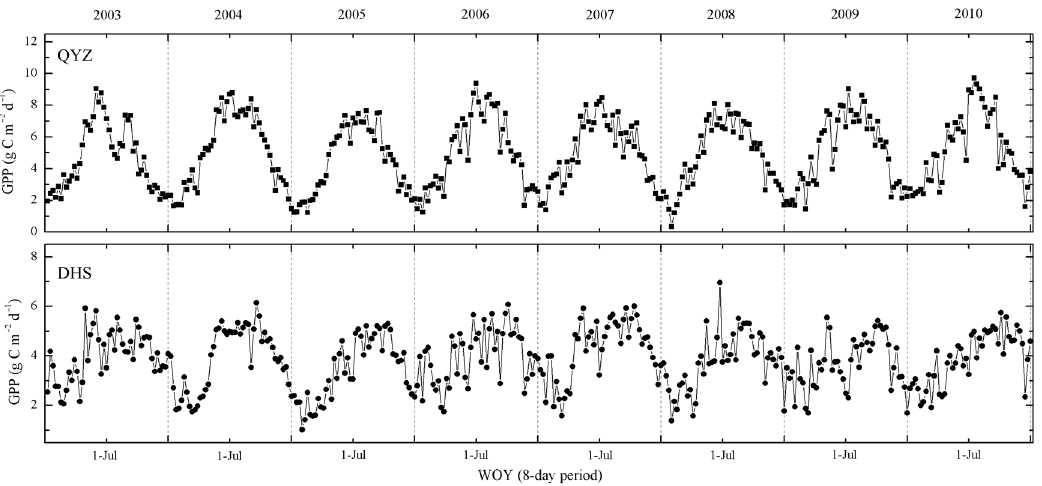
Figure 2. Site-level GPP observations at the two subtropical forest flux sites (QYZ and DHS) for 8-day periods from 2003 to 2010, respectively. For x -axis, the data refer to week of year (WOY) ranging from 1 to 46.